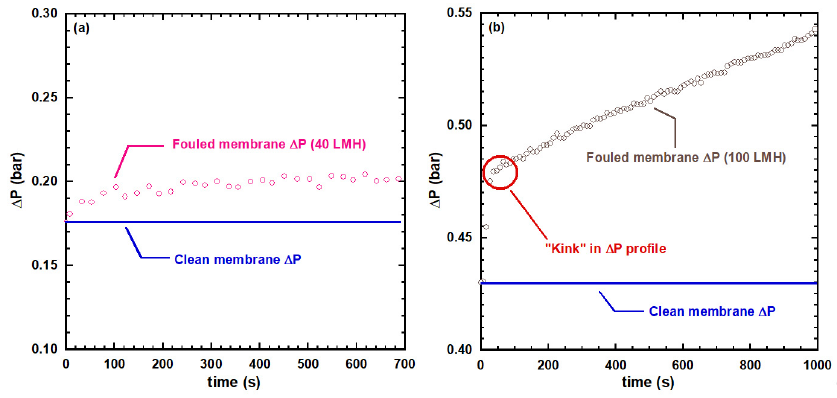
Figure 5. Constant flux filtration conducted with 200 ppm 0.22 µm latex bead suspension below